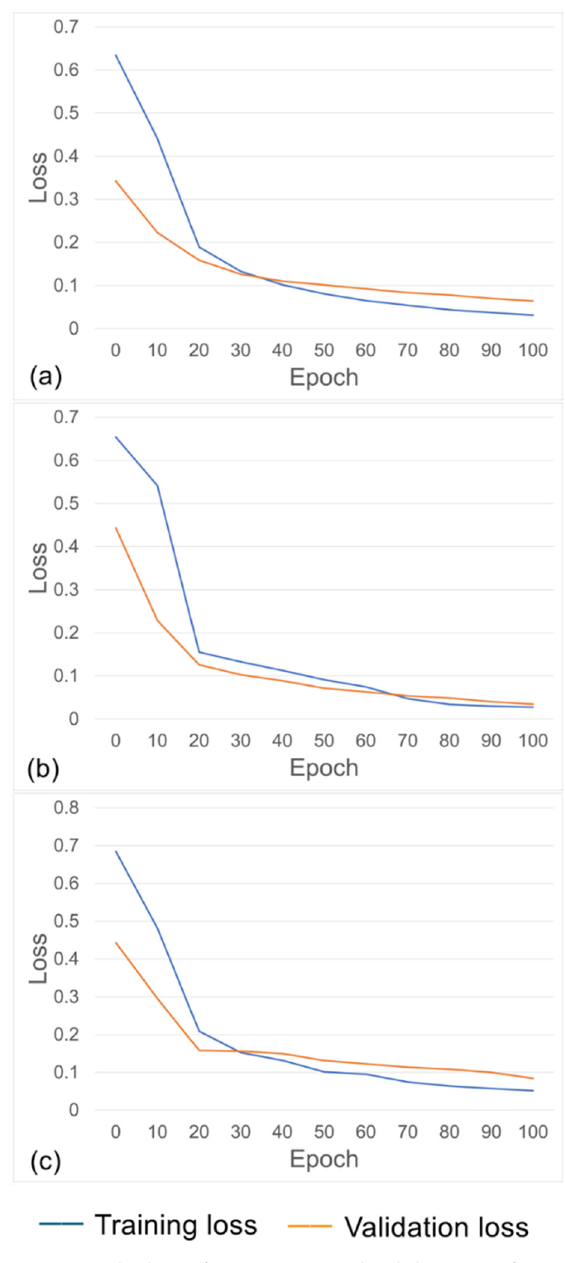
Figure 5. The loss of training set and validation set from the experiment of ( a ) West Pacific, ( b ) Southern Ocean and ( c ) East Pacific.